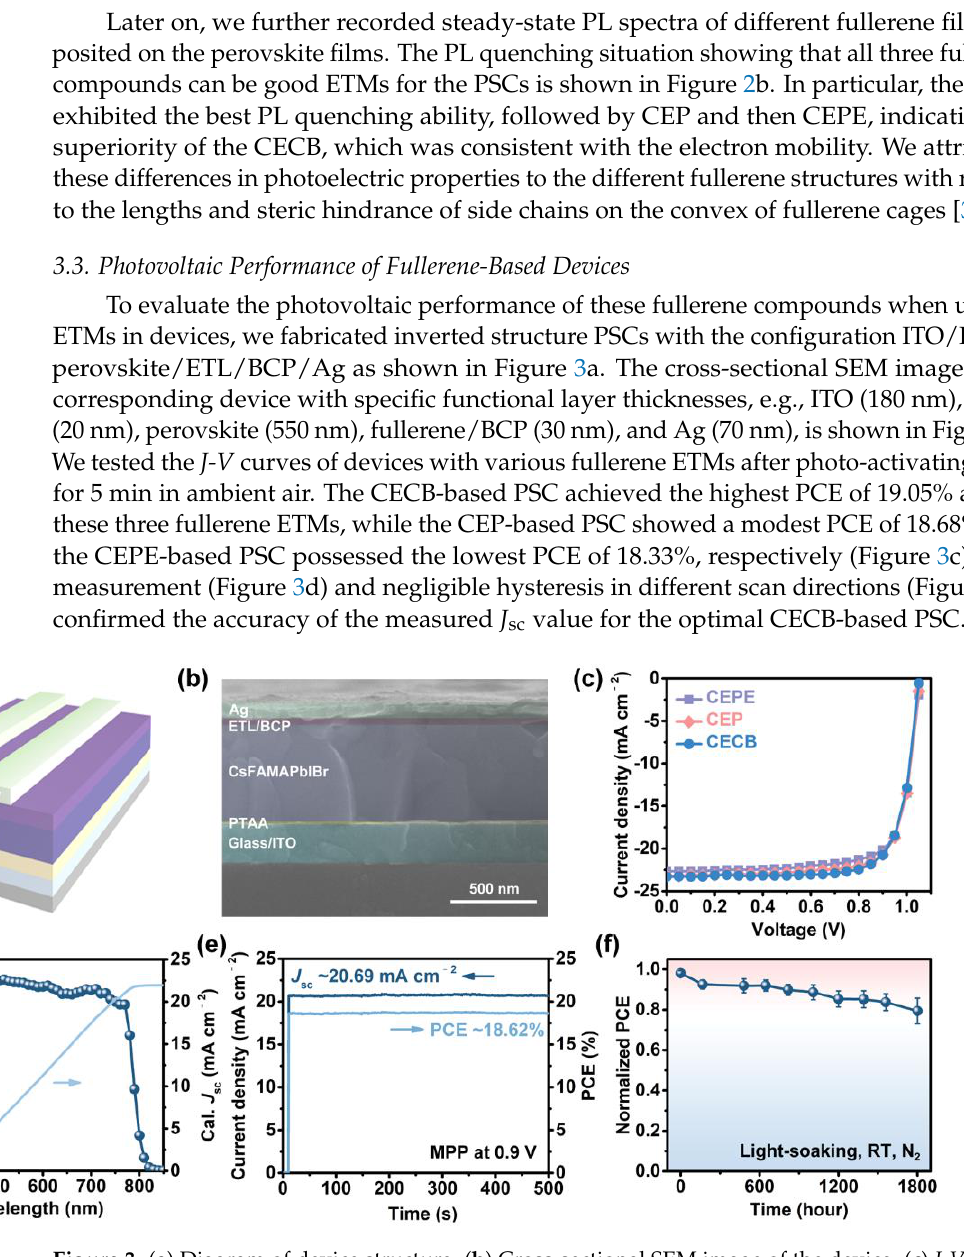
Figure 3. ( a ) Diagram of device structure. ( b ) Cross-sectional SEM image of the device. ( c ) J-V curves of champion devices based on different fullerene ETMs. ( d ) EQE and calculated J sc curves of the champion CECB-based device. ( e ) Steady-state output test of the champion CECB-based device at MPP. ( f ) Light-soaking stability of the champion CECB-based device.